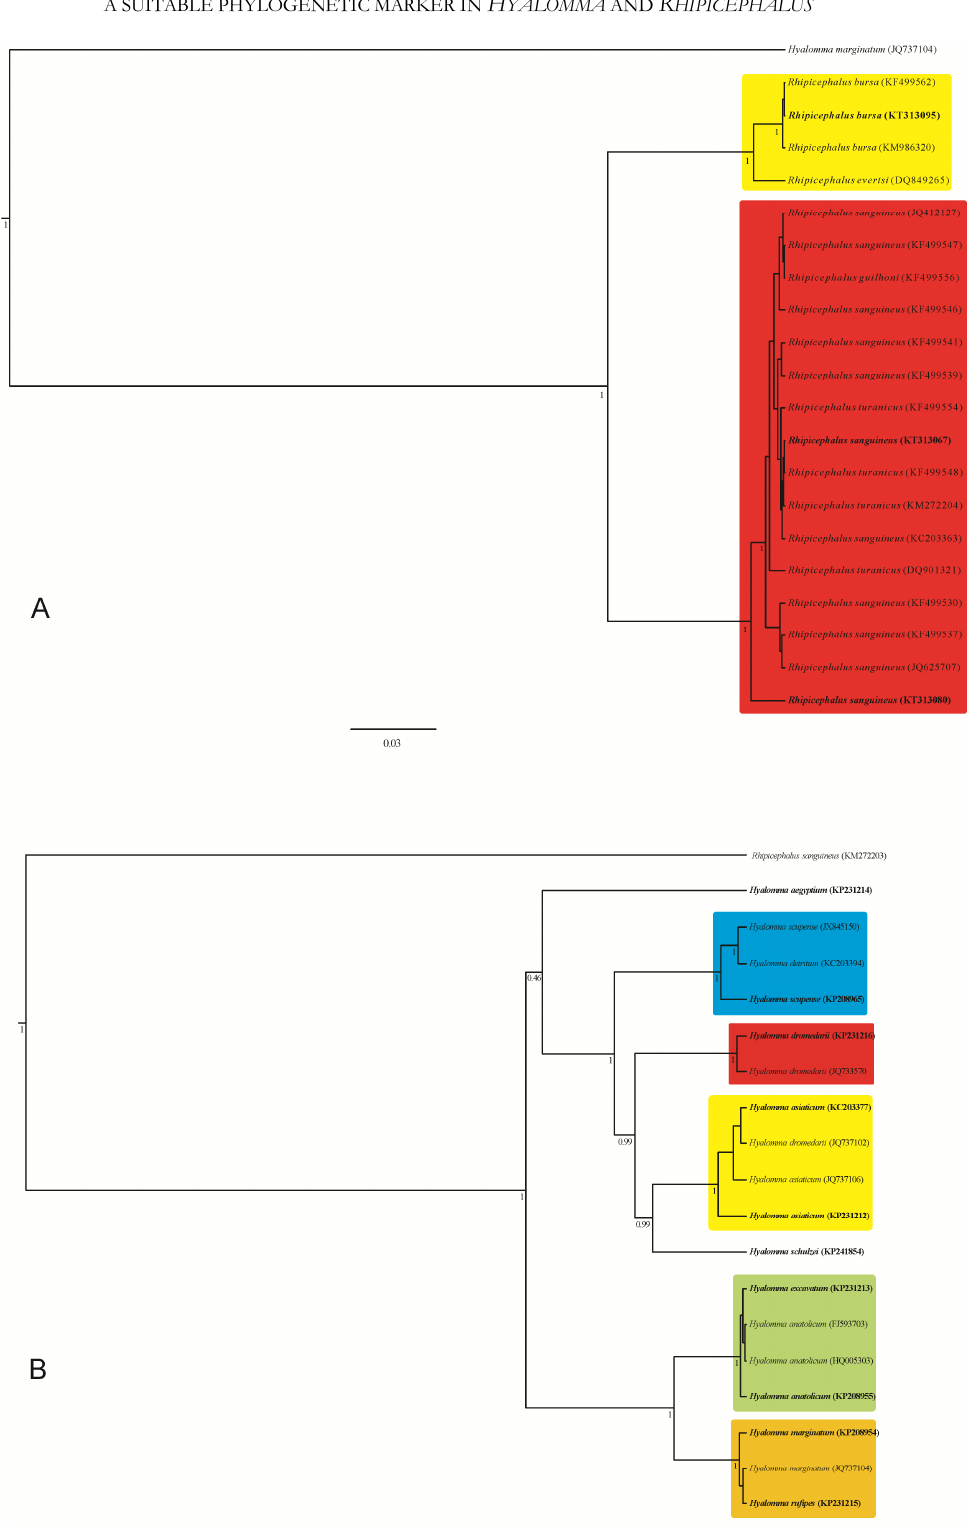
F IGURE 1- The phylogenetic relationship reconstructed using BEAST package based on Bayesian Inference (BI) indicating of Rhipicephalus (A) and Hyalomma ITS2 sequences of GenBank and sequences of the present study. Taxa of the present study are bold and GenBank accession number of each taxa are given in the parenthesis. Nodes indicated with credibility